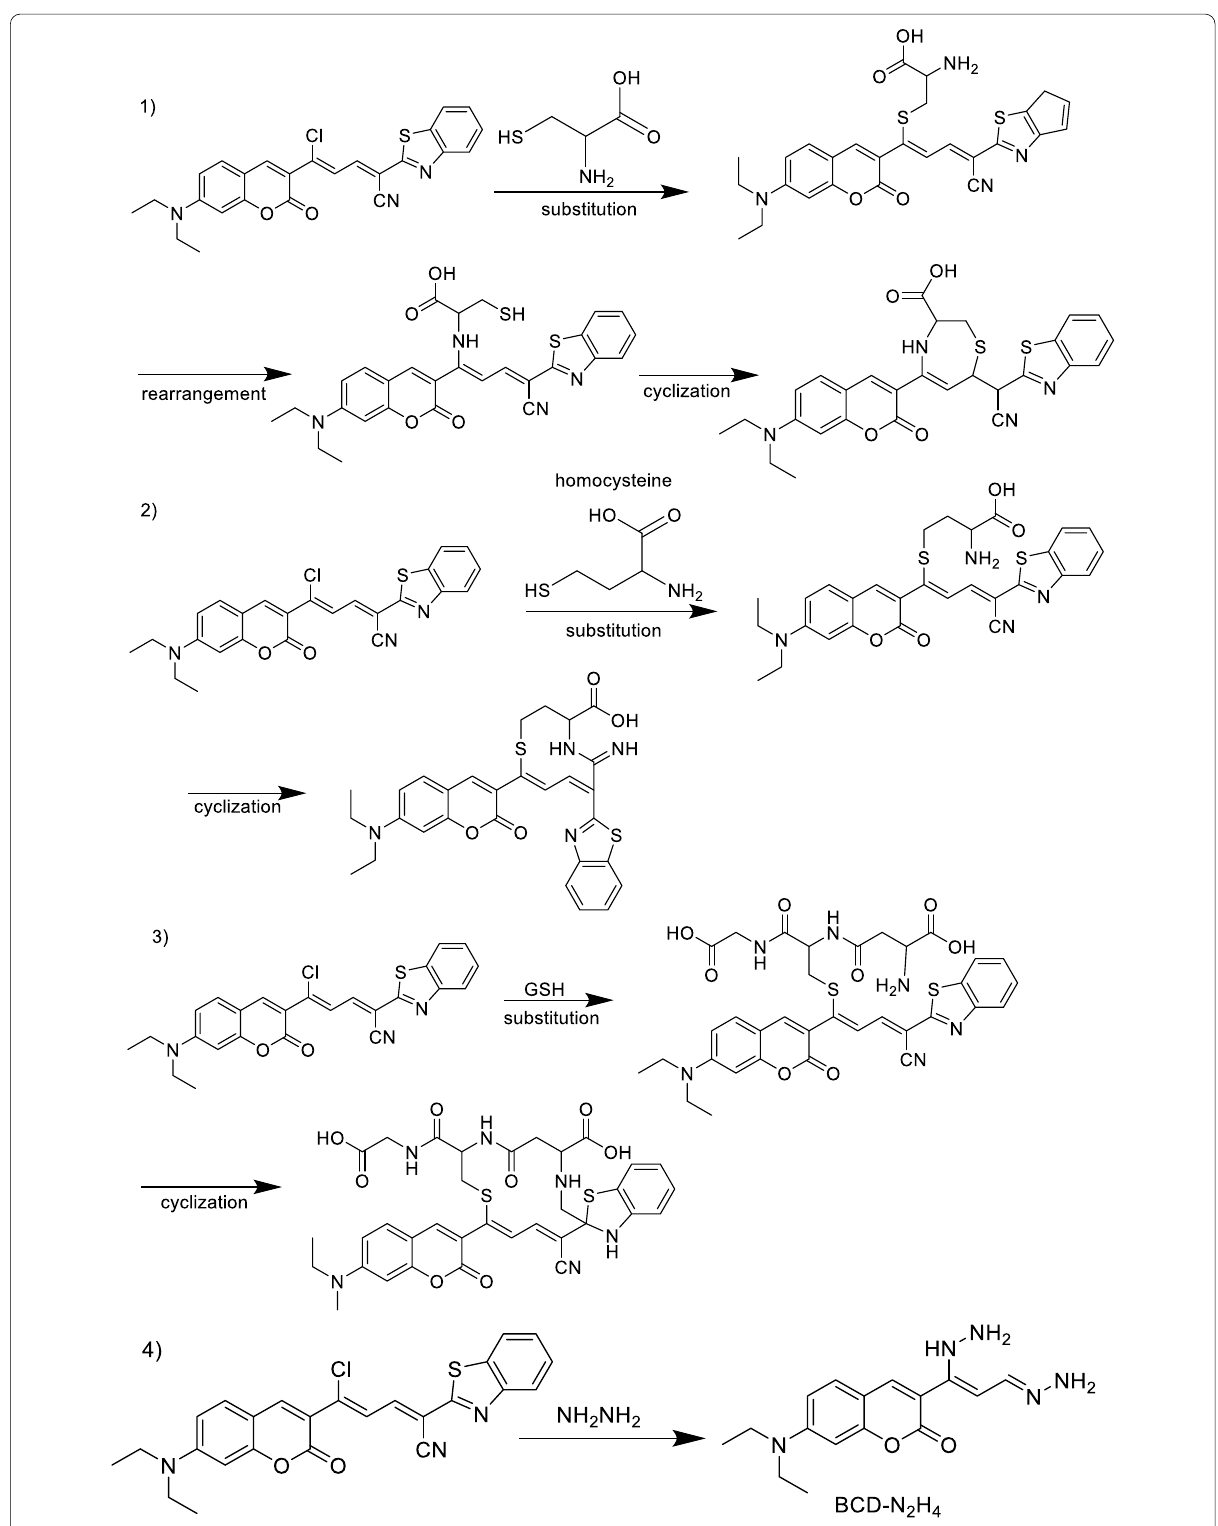
Scheme 2 Possible sensing mechanism of probe BCD: (1) proposed mechanisms of probe BCD with Cys; (2) proposed mechanisms of probe BCD with Hcy; (3) proposed mechanisms of probe BCD with GSH; (4) proposed mechanisms of probe BCD with N 2 H